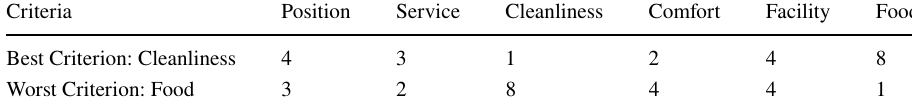
Table 10 Pairwise comparison vector based on PRs